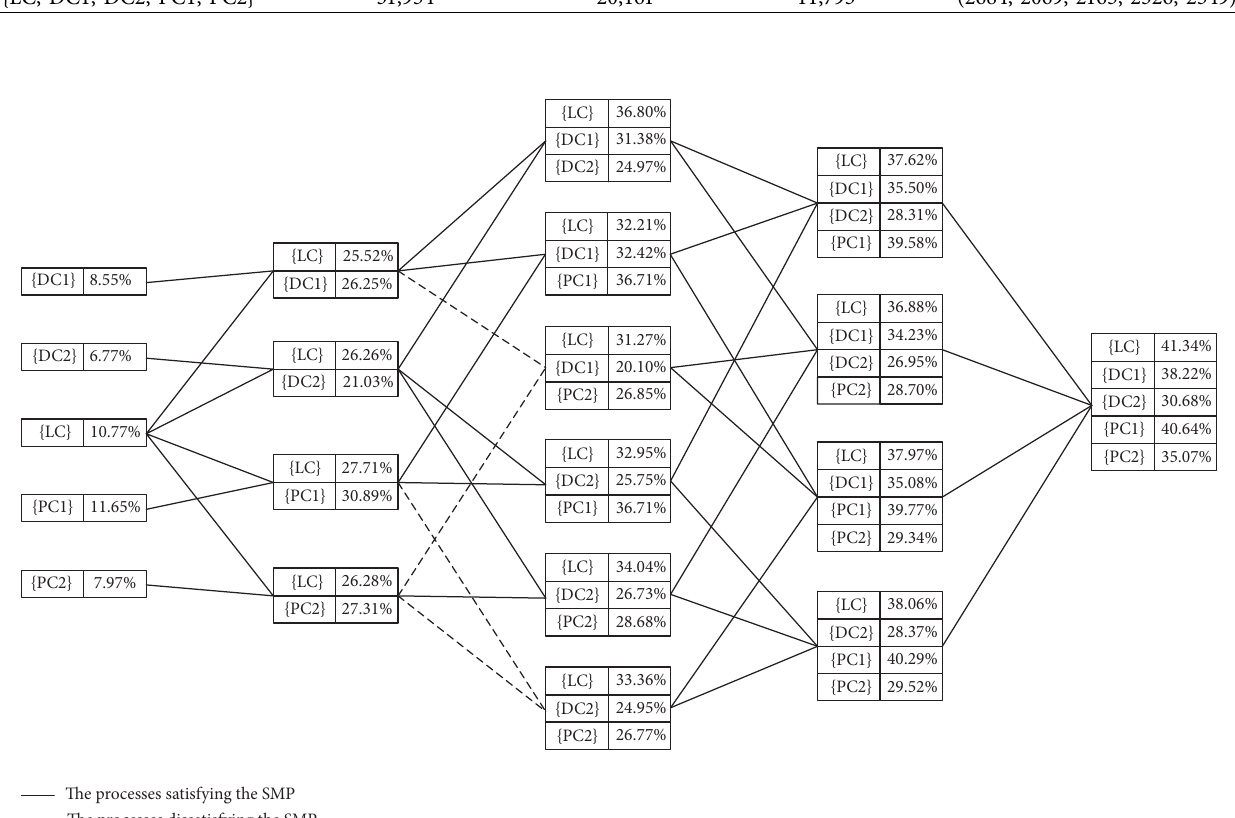
Figure 10: Cost reduction percentages when new members join the